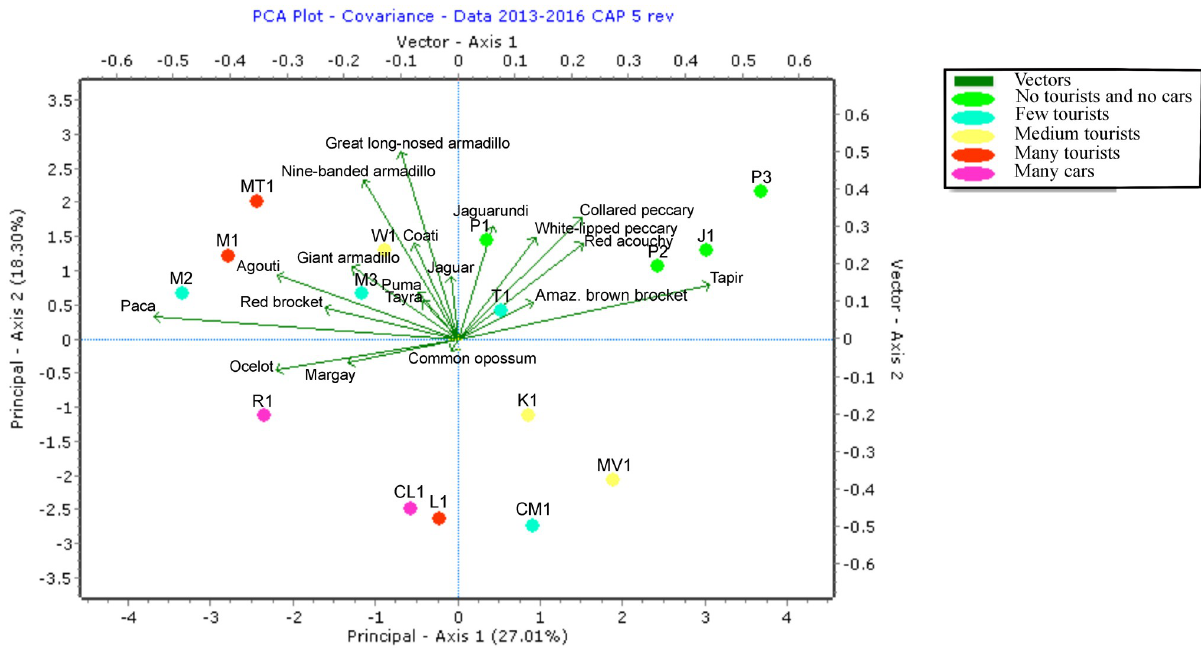
Fig 6. PCA plot of camera stations with species grouped according to level of